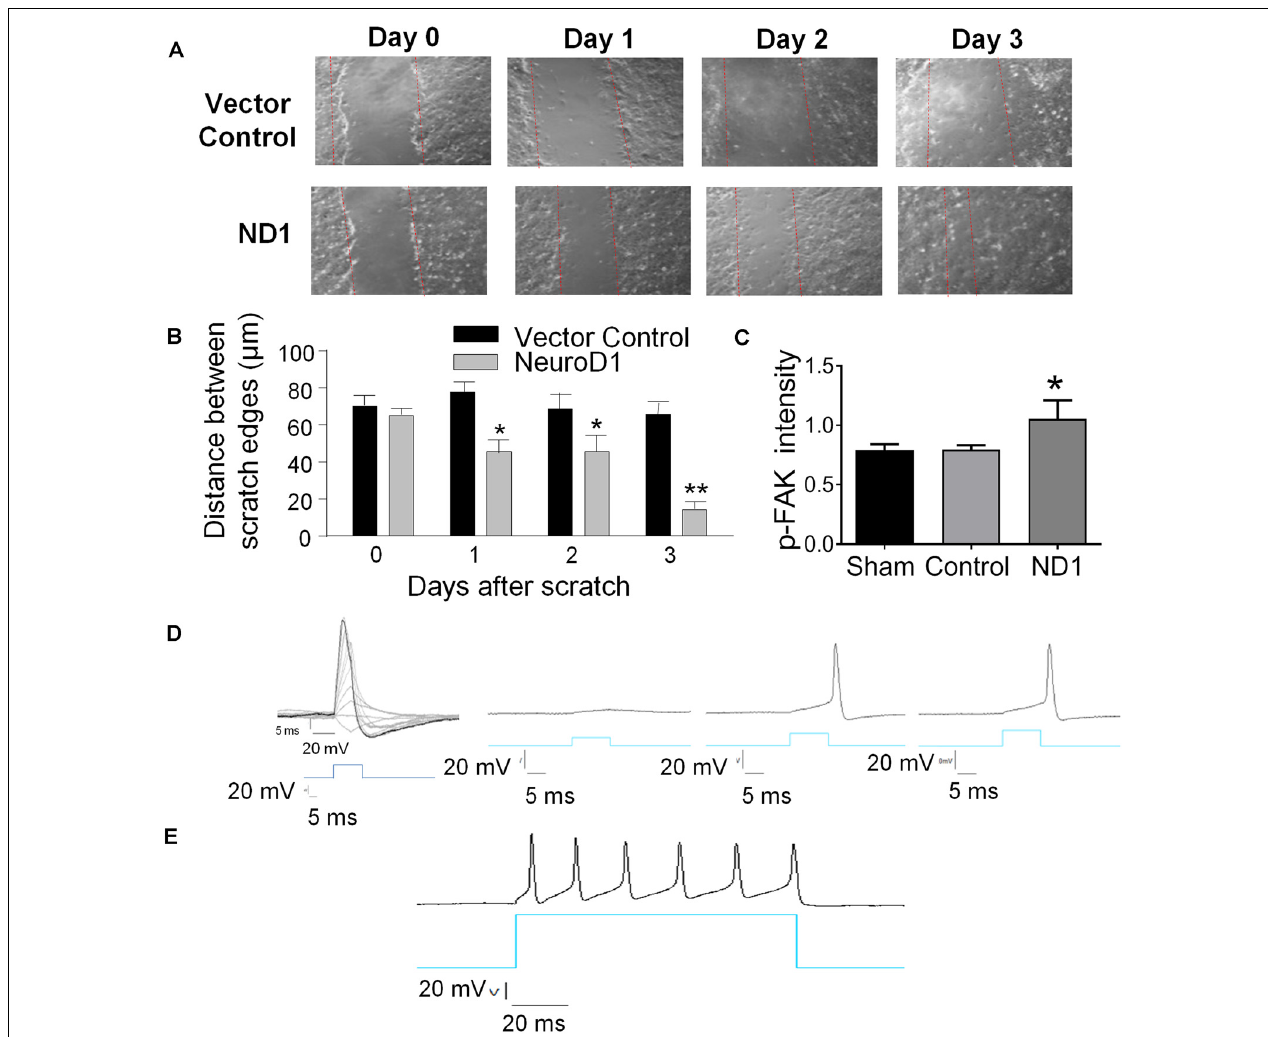
FIGURE 2 | Reprogramming induced cellular changes and functional activities in vitro . The ND1-mediated astrocytes reprogramming was monitored in cultures and functionally characterized. (A,B) Two weeks after ND1 virus or empty control vector transduction, astrocyte cultures were challenged by the scratch test to measure the motility of reprogrammed cells. From day 1 after the scratch insult, the damaged area recovered significantly faster by migrating cells in cultures infected by ND1 compared to the vector control culture. N = 3 cell cultures. Two-way ANOVA (Interaction: F (3,24) = 11.15, ∗∗∗ p < 0.0001; Time: F (3,24) = 18.66, ∗∗∗ p < 0.0001; ND1: F (1,8) = 53.87, ∗∗∗ p < 0.0001) followed by Holm–Sidak’s multiple comparisons test: * p < 0.05 and ** p < 0.01 for ND1 vs. empty vector control. (C) Effect of the scratch test on the expression of migration factor focal adhesion kinase (FAK) in reprogrammed cells. In line with the increased motility 3 days after